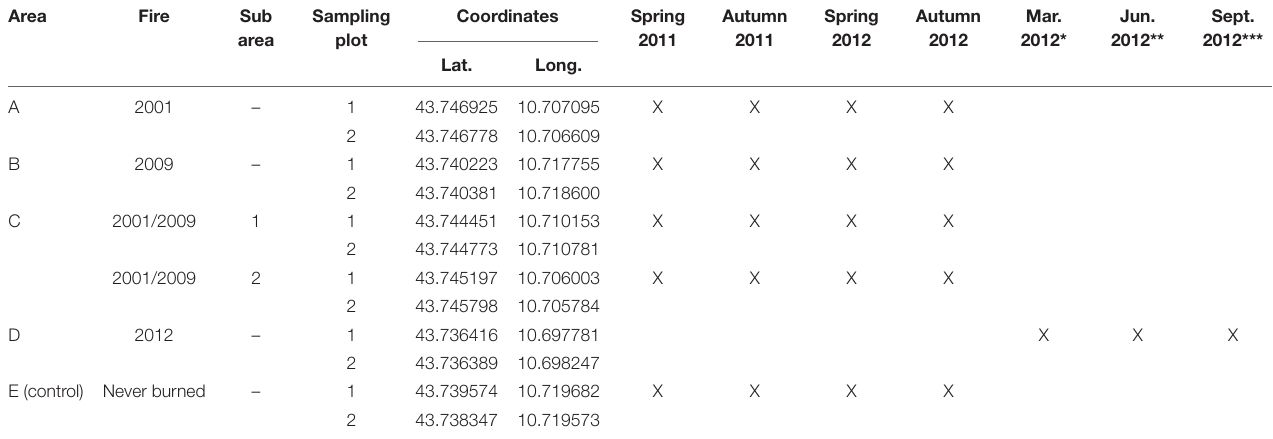
TABLE 2 | Date of sampling.